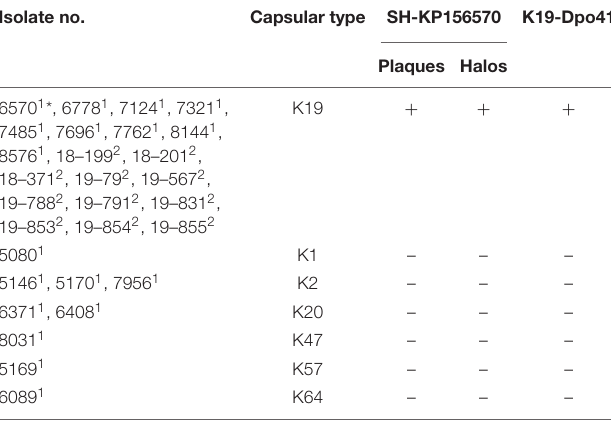
TABLE 1 | Host spectrum of phage SH-KP156570 and depolymerase K19-Dpo41 against 29 K. pneumoniae strains. Isolate